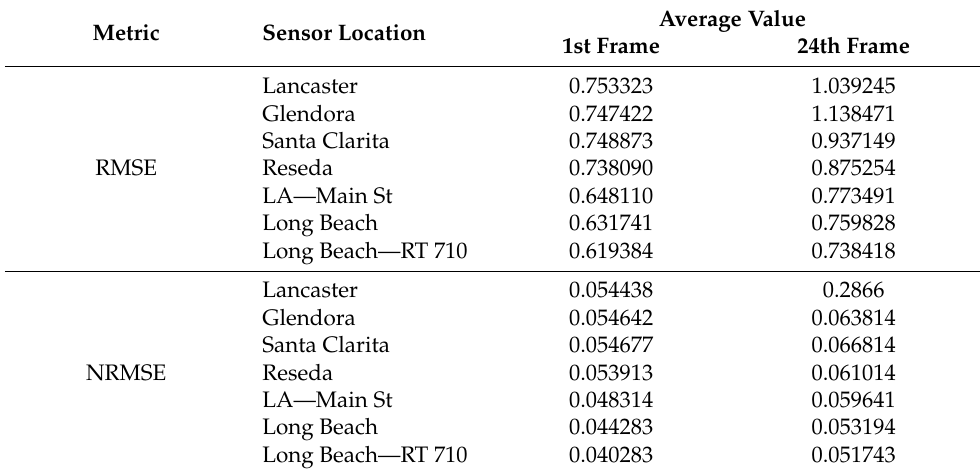
Table 1. RMSE (in µ g/m 3 ) and NRMSE error values averaged over 24 frame bundles (First Frame Averages and 24th Frame Averages) of test set for each sensor location.